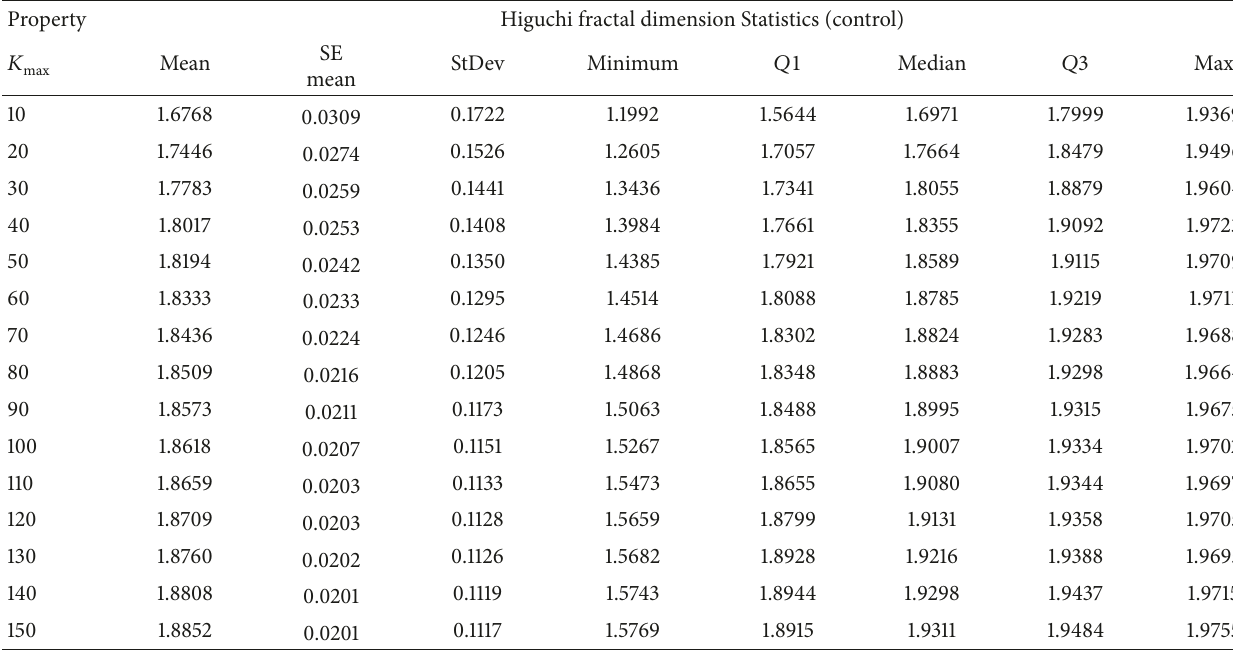
Table 4: Higuchi fractal dimension statistics through 𝐾 max between 10 and 150 at intervals of 10 in the control protocol. Property